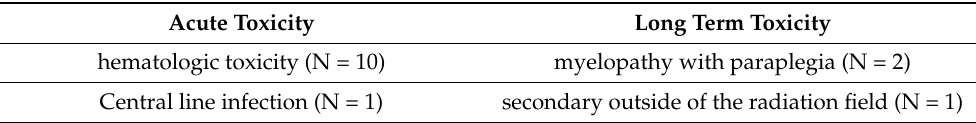
Table 3. Overview of higher-grade acute and long-term toxicity in a cohort of 20 patients with relapsed high-risk neuroblastoma.